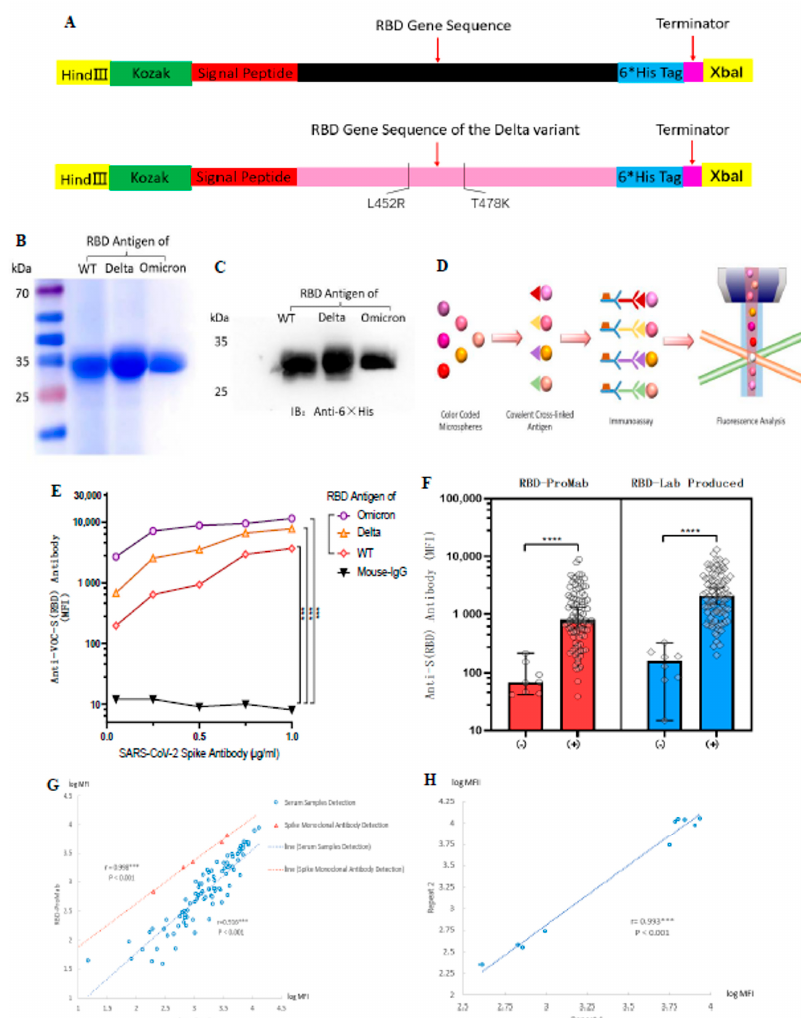
Figure 1. Design and generation of the ACE-2 receptor binding domain (RBD) soluble antigenic protein of SARS-CoV-2 and its VOCs. Luminex technology was used to develop a method to detect antibody levels after vaccination. ( A ) Cloning of the RBD gene. The RBD protein of the Delta variant had only two amino acid mutations. ( B , C ) Expression and purification of soluble antigenic protein RBD. ( D ) Schematic illustration of Luminex technology. ( E ) SARS-CoV-2 spike monoclonal antibody to validate WT-RBD and Delta-RBD antigen protein functions. The mean fluorescence intensity (MFI) values represent an indicator for the assessment of antigen-antibody binding. Mouse IgG was used as a negative control group for statistical analysis using Dunnett’s test. ( F ) Comparison of RBD-ProMab with RBD-Lab produced in negative ( n = 8) and positive sera ( n = 85). MFI values were logged, and the means were compared using independent sample t-test. ( G ) Correlation of RBD-ProMab and RBD-Lab produced antigenic protein function was analyzed by applying serum samples ( n = 93) and monoclonal antibodies. ( H ) Correlation of anti-RBD IgG signal strength in two replicates of the same serum sample ( n = 10). ( G ) and ( H ) MFI values were logged, and correlation analysis was performed using Pearson test. * p < 0.05 and *** p < 0.001.